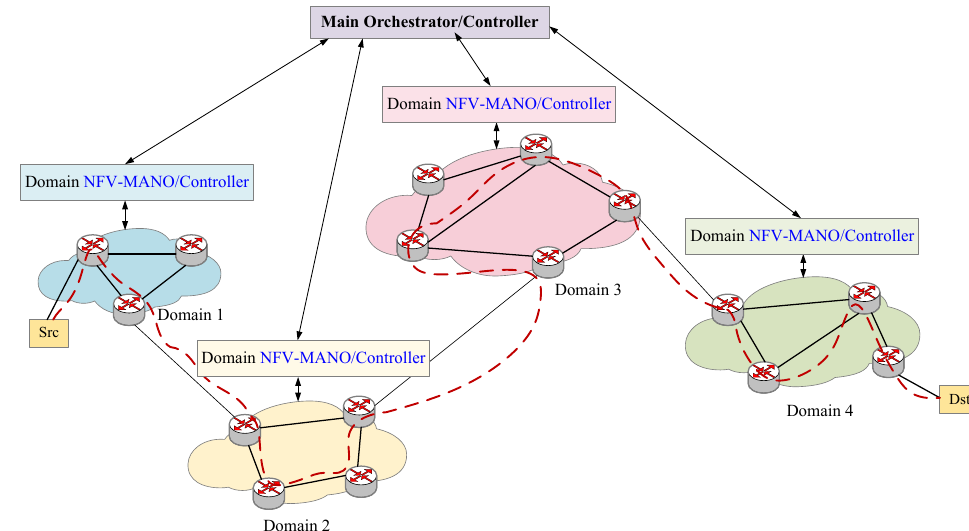
Figure 2. Multi-domain SFC